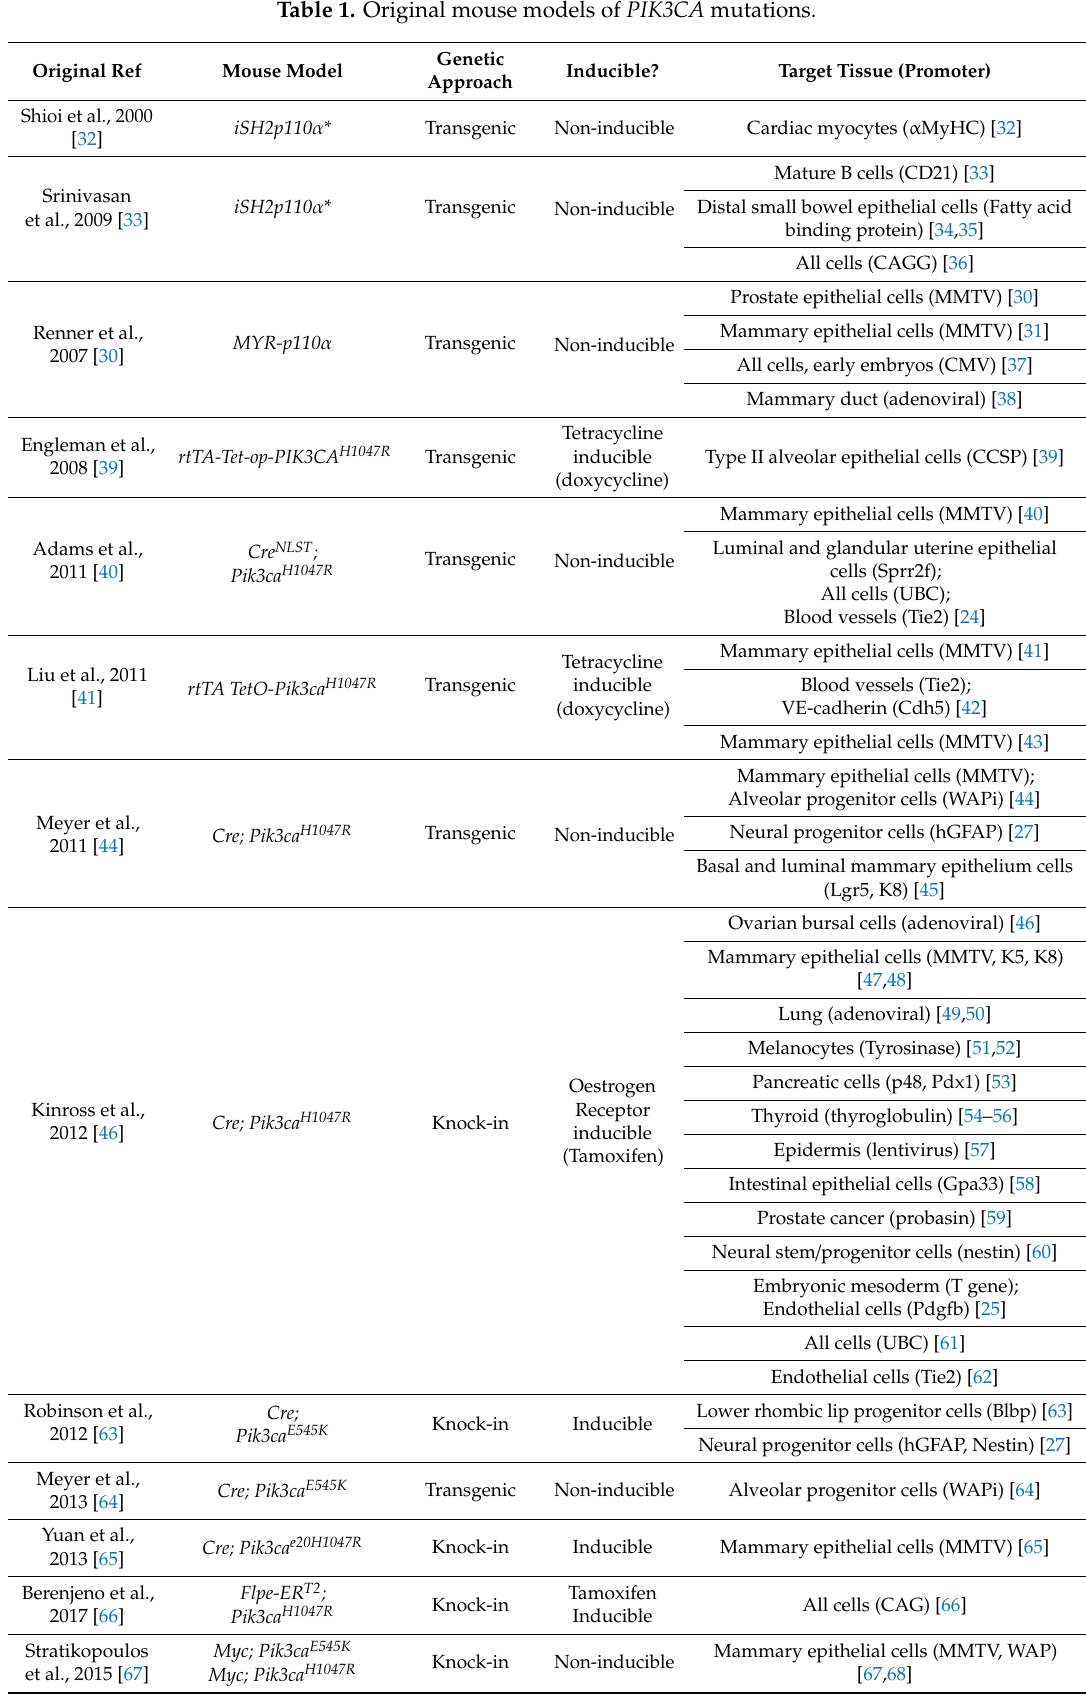
Table 1. Original mouse models of PIK3CA